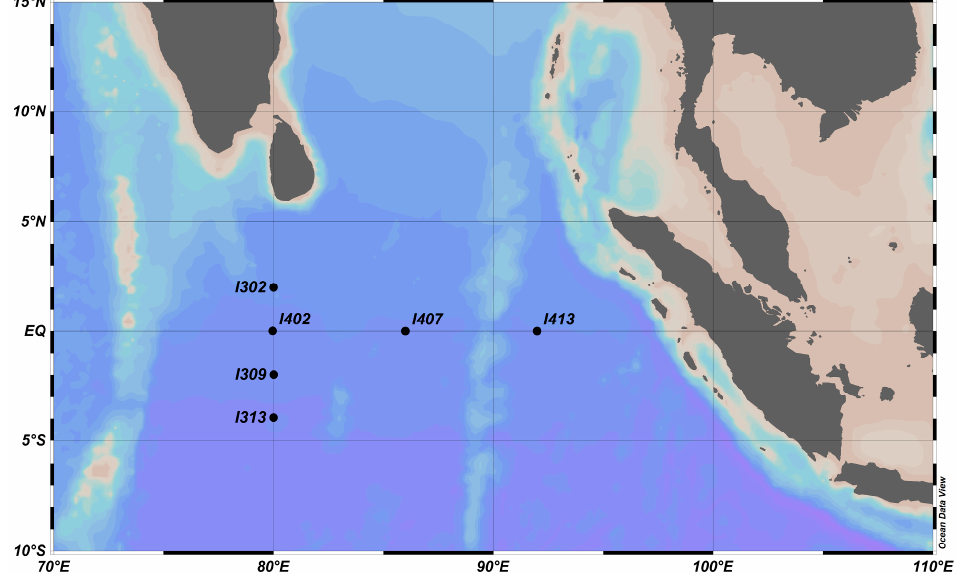
Figure 1. Map of the sampling stations on the equatorial eastern Indian Ocean. Three stations (I302, I309, and I313) were near the equator, and three stations (I407, I407, and I413) were on the equator. Sampling stations were plotted using the Ocean Data View software (https://odv.awi.de, accessed